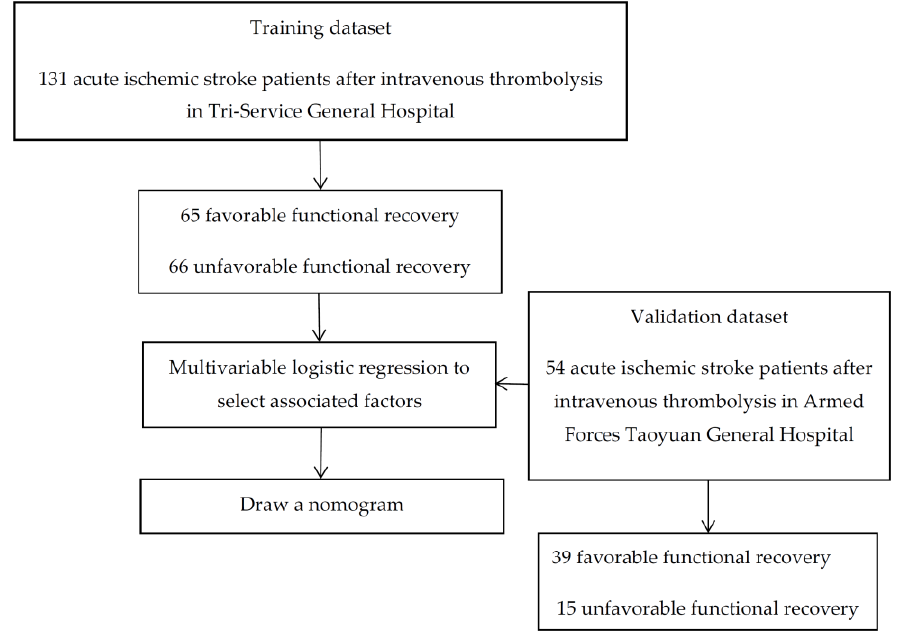
Figure 1. Flow chart of intravenous thrombolysis prognosis.